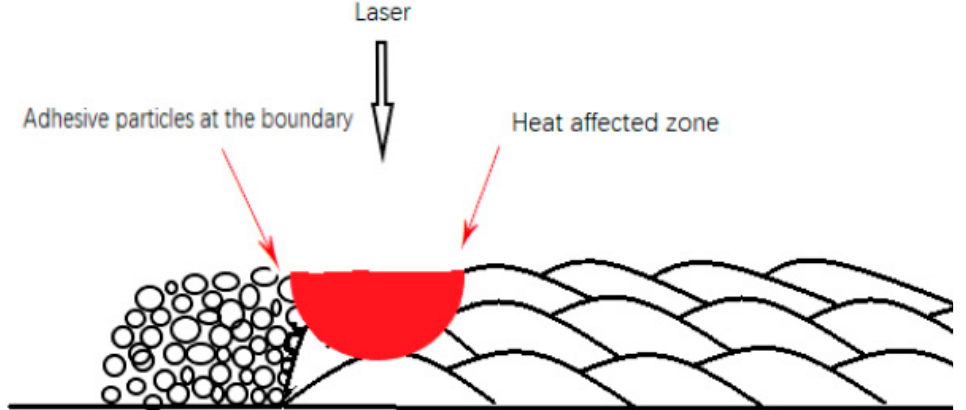
Figure 4. Diagram of incomplete melted powder particles adhered to the surface.